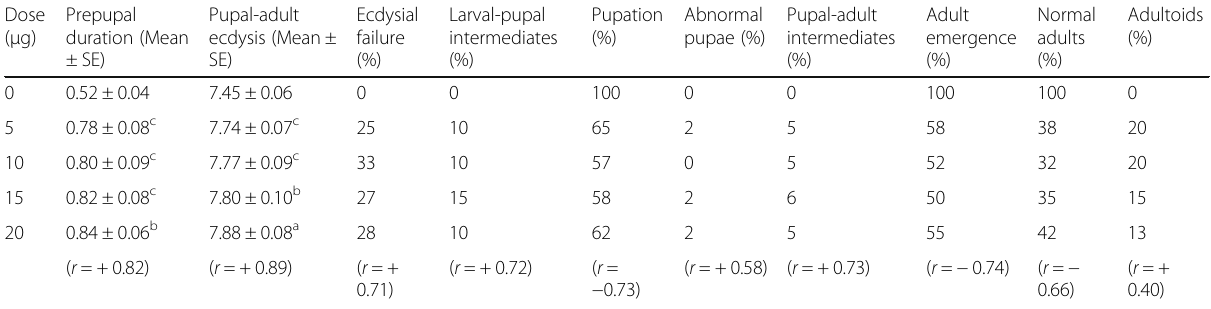
Table 2 Topical administration of root extracts of Withania somnifera on prepupal stage of Spodoptera litura ( n = 20; replicate = 3) Dose Prepupal ( μ g) duration